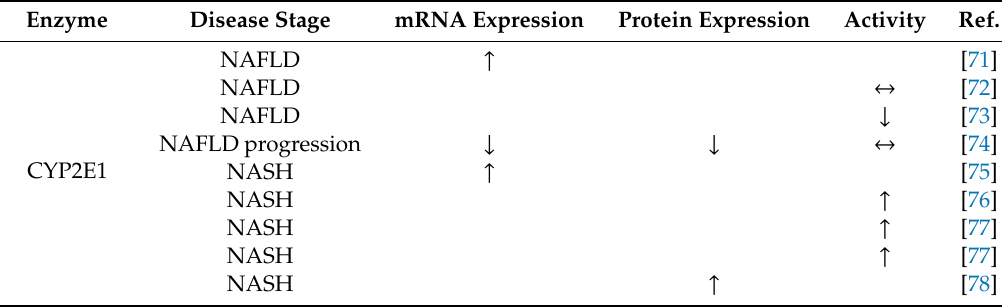
Table 1. Changes in expression and activity levels of major cytochrome P450 enzymes in humans. CYP, cytochrome P450; NASH: nonalcoholic